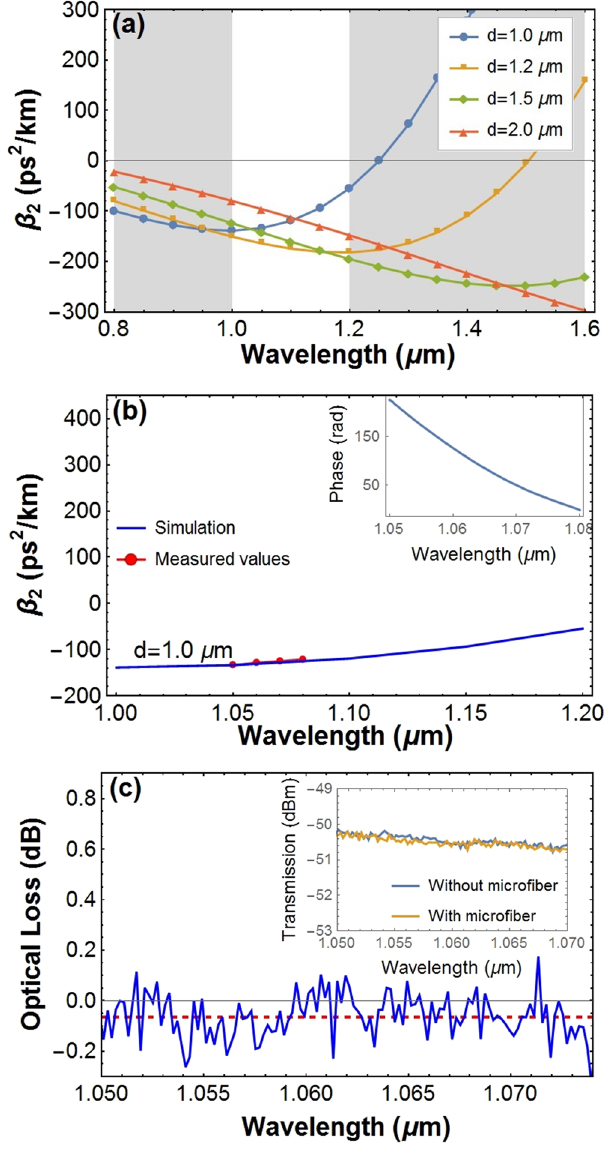
Figure 1. ( a ) Calculated β 2 for optical microfibers with a diameter of 1.0, 1.2, 1.5, and 2.0 μ m, respectively. ( b ) The measured (red line) and the calculated (blue line) β 2 for an optical microfiber with a diameter of 1.0 μ m, which was chosen in accordance with the one used in the experiment shown in Fig. 2. The inset shows the measured relative phase delay, from which we obtained the β 2 . ( c ) The measured insertion loss of the optical microfiber in (b). The inset shows the transmission spectra of fibers spliced with and without optical microfibers, and the difference of the two curves is the insertion loss. The red dashed line gives the average loss, i.e., − 0.06 dB. The points above the zero-loss line are attributed to the spectral fluctuations of the broadband source we